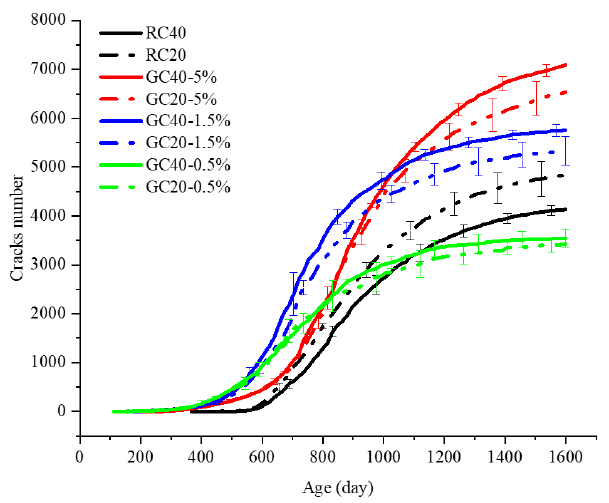
Figure 7. AAR-induced microcrack number over time.